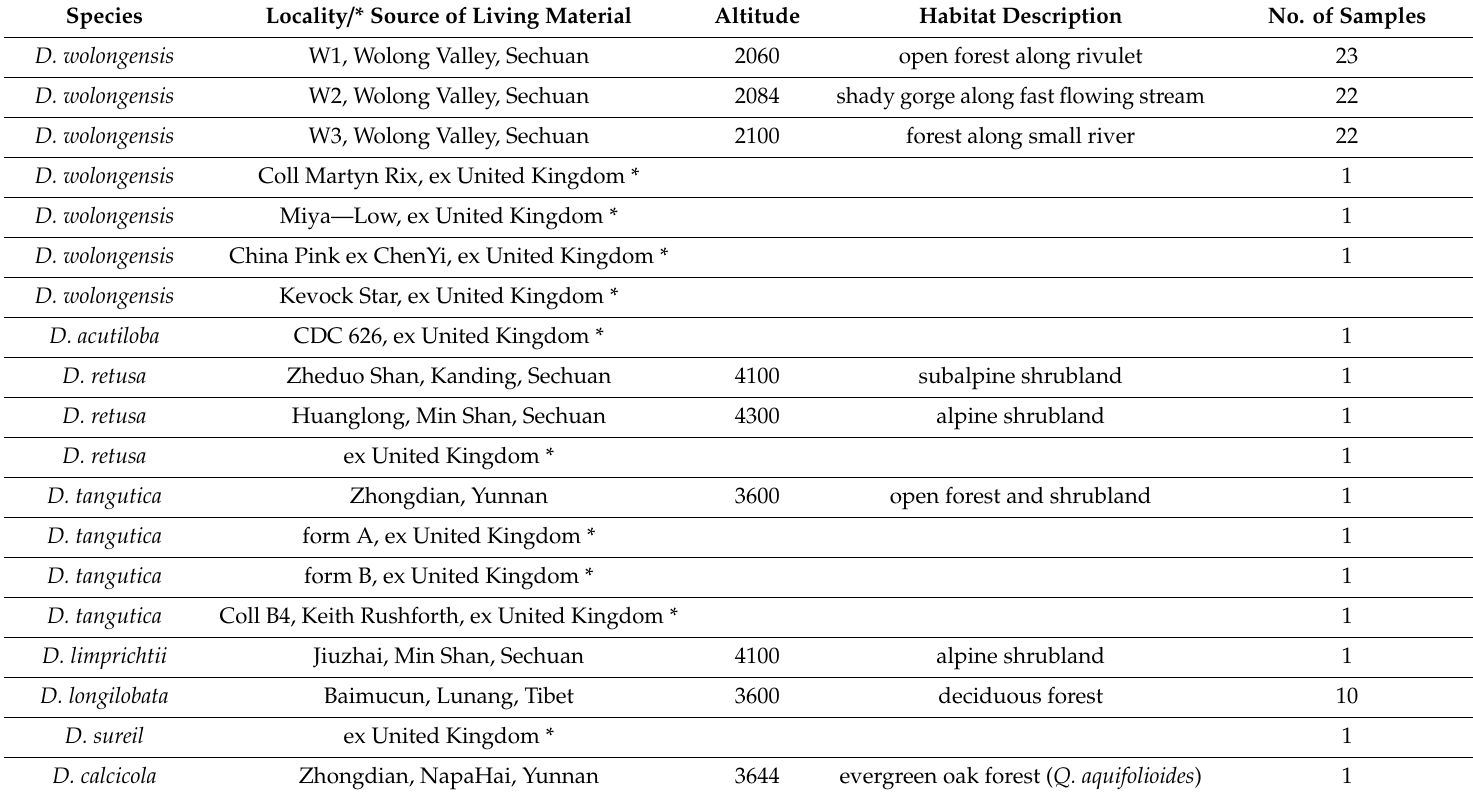
Table 1. Investigated species and localities / sources of living material of Daphne section Rehdera .